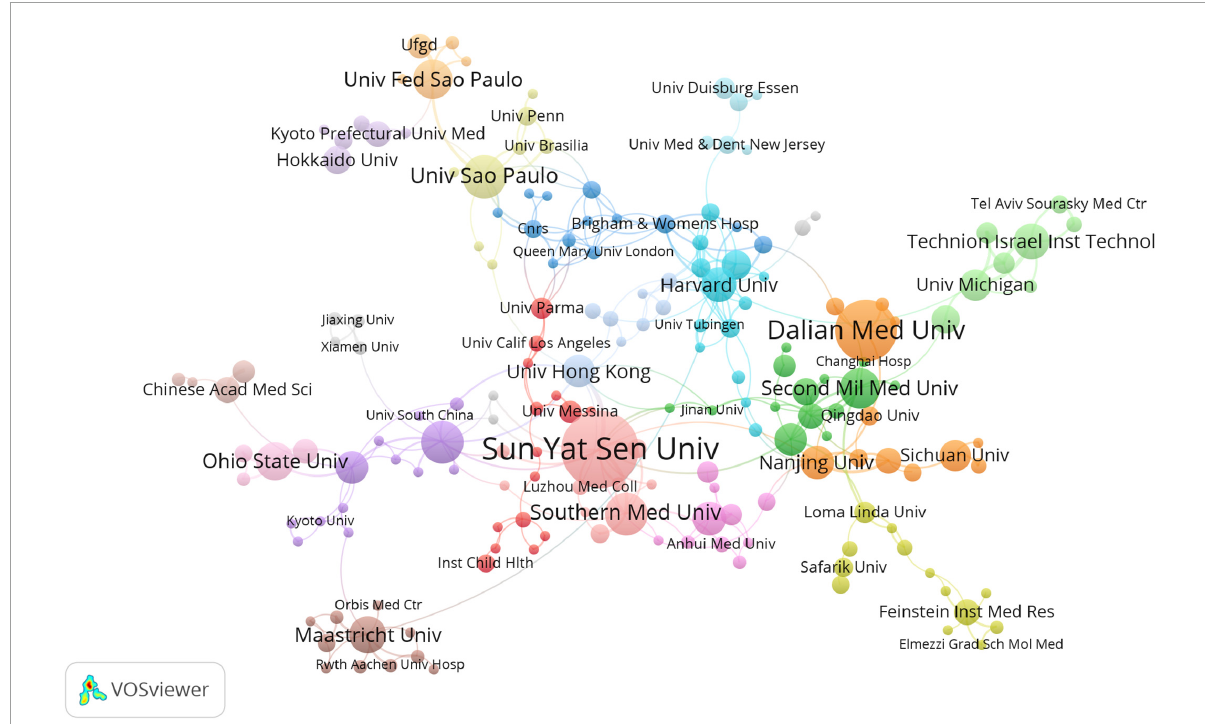
FIGURE3 Visualization diagram of each institutions regarding intestinal I/R. Applying VOSviewer, the collaborative network of institutions. Different nodes represent different institutions. Different colors represent clusters with different affinities. Sizes of nodes ars based on publications of